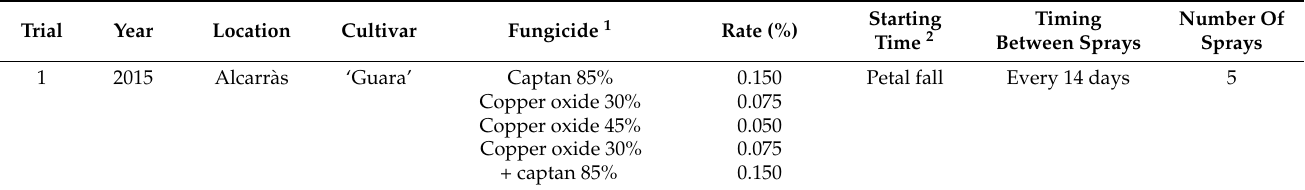
Table 3. Trials of fungicides against the almond red leaf blotch conducted in 2015–2019 in the Lleida region, Spain, using single